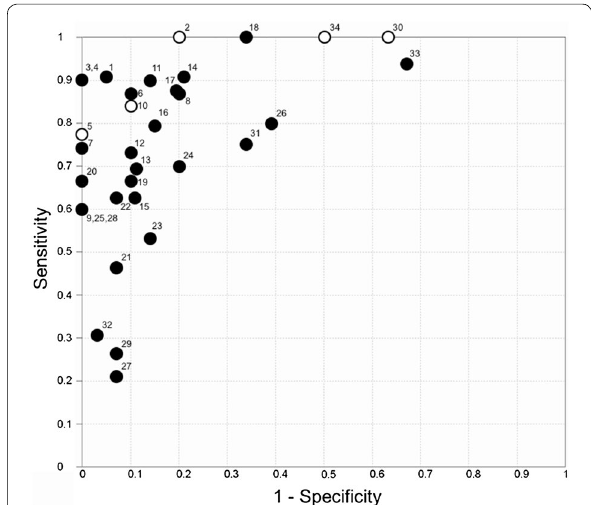
Fig. 2 Receiver operating characteristics curve with all methods found in the literature search of assessment volume responsiveness in spontaneous breathing patients. Closed circles represent studies including spontaneous breathing patients without ventilator support; open circles represent studies including patients under mechanical ventilation during spontaneous mode and spontaneous breathing without ventilator support. 1 ∆PPV of 52%; 2 ∆SV-PLR TTE >13%; = =